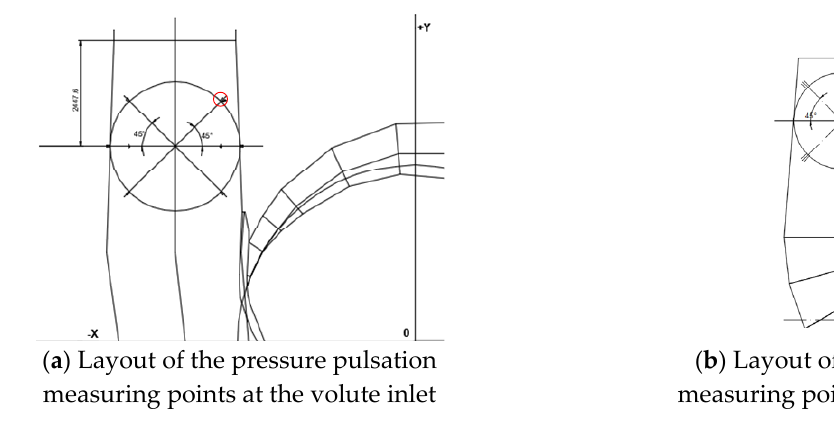
( d ) 0.75 T Figure 4. Pressure distribution in the middle section of draft tube.